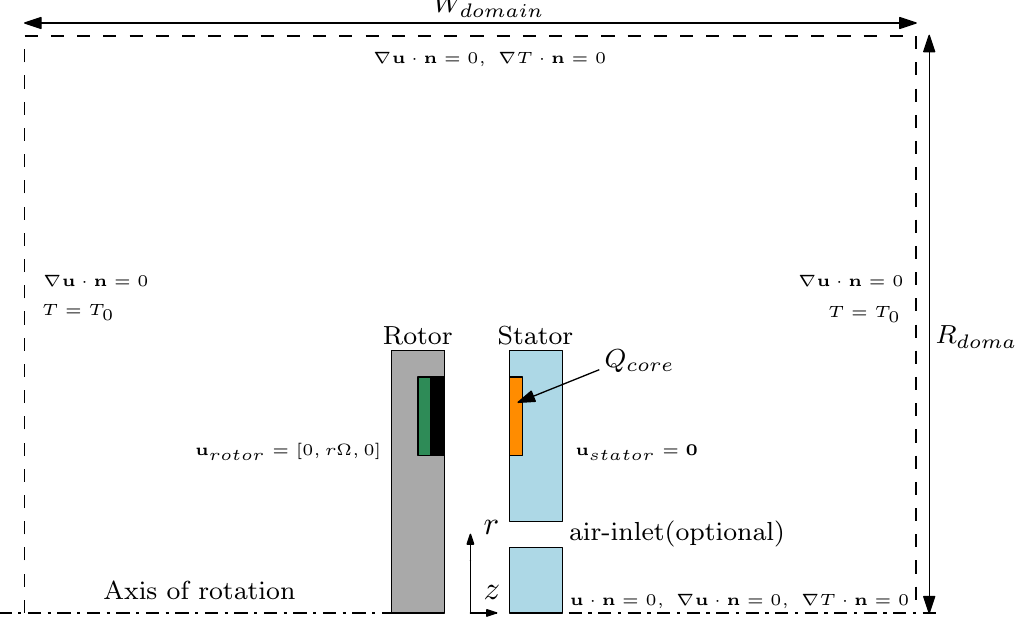
Figure 11. Numerical domain and the corresponding boundary conditions of both the fluid and temperature models. The colored areas correspond to solid parts and are neglected in the fluid simulation, as merely the boundaries obtain a prescribed velocity. The orange sub-domain corresponds to the core which has a heat source assigned to